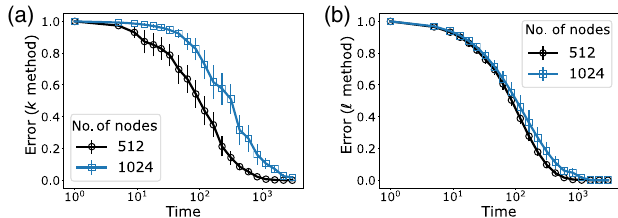
FIG. 3. Training spring networks by modifying (a) spring constants or (b) rest lengths. The error in the target edge lengths is shown as a function of the number of training iterations for N ¼ 512 (black circles) and N ¼ 1024 (blue squares) networks. Training by coupled learning is successful for either the stiffness or rest length degrees of